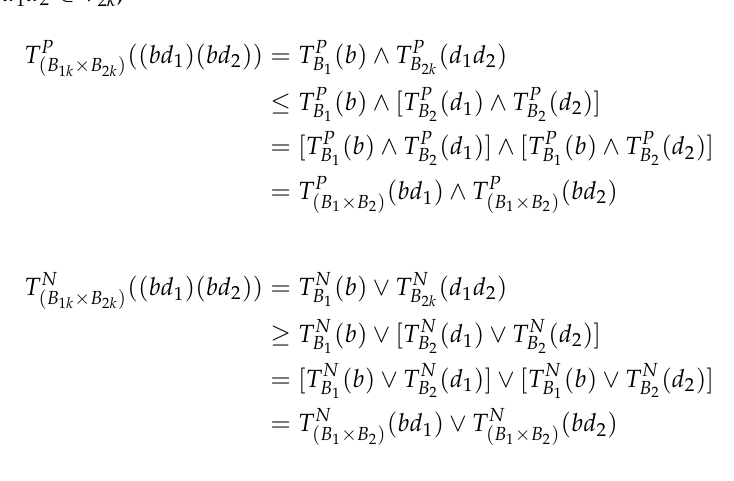
Figure 2.12: ˇ G b 1 × ˇ G b 2